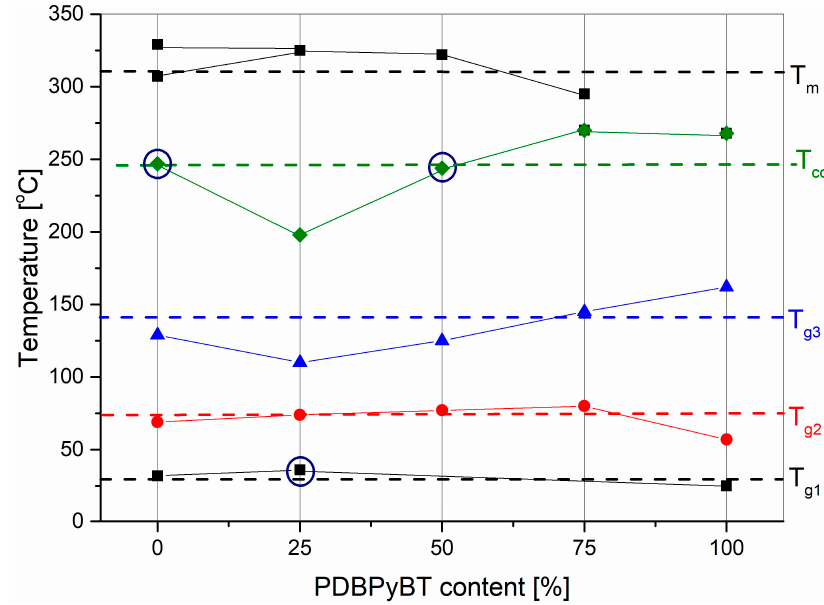
Figure 6. Phase diagram of PDPP4T:PDBPyBT blend films, prepared based on DSC and temperature ellipsometry. Thermal transitions marked with a dark blue circle were detected only in VTSE measurements. T g is the glass transition, T cc is the cold crystallization temperature and T m is the melting point.